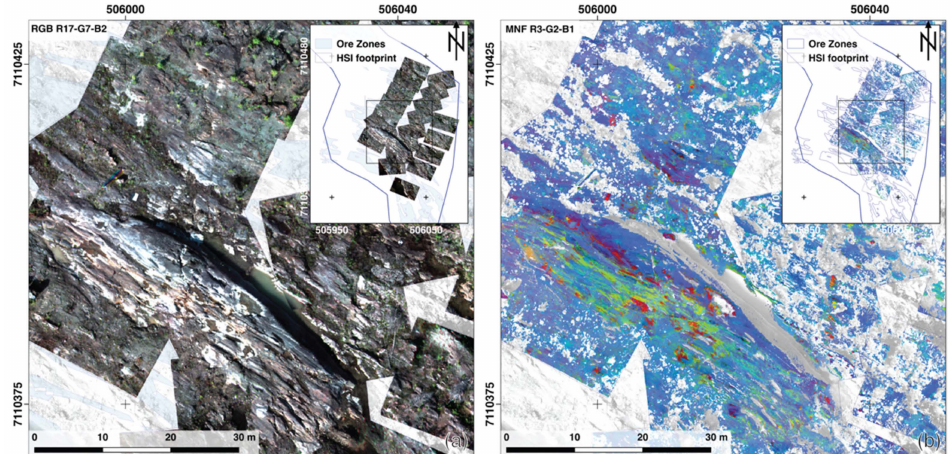
Figure 7. Results from hyperspectral data collected from the multicopter. ( a ) RGB plot (bands 17, 7, 2) of the HSI mosaic from the eastern part of the outcrop (the inset map shows the whole mosaic). The map enhances surface details and includes an area with pronounced occurrences of gabbroic host rock and iron ore lenses. ( b ) RGB plot of eigenimages 3, 2, 1 from the same area after a MNF transformation was applied to the hyperspectral mosaic. The eigenimages of the MNF outline surfacing shapes and textures. Red and green colors highlight outcropping iron stains and blue colors are associated with area of the host rock surface and remaining soil–vegetation